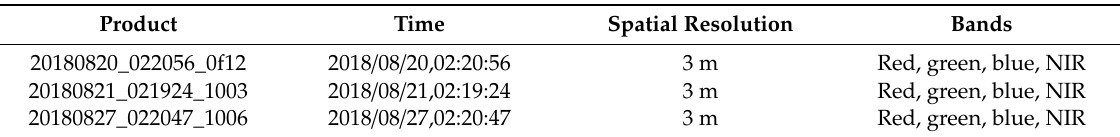
Table 3. Information of three Planet